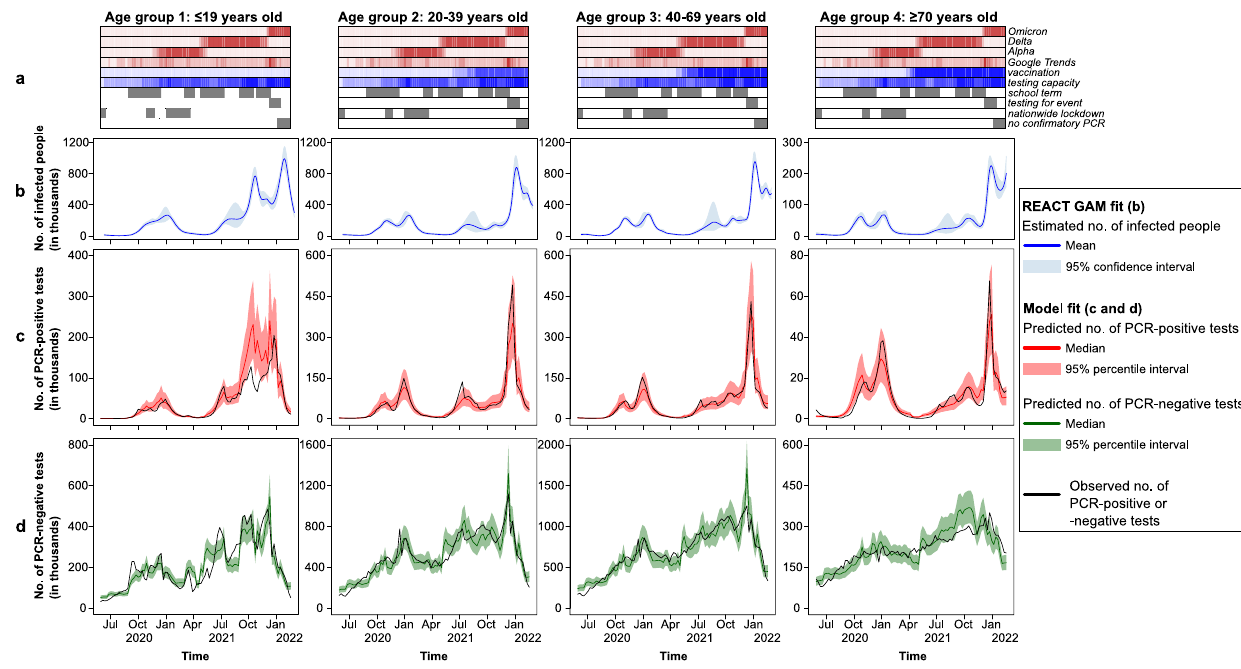
Fig. 4 | Predictive posterior check of the best- fi tting model by age group and overtime. Row a showsthetemporaltrendofvariablesincludedinthebest- fi tting model, and row b shows the temporal trend of the number of infected (mean, 95% con fi denceintervals)estimatedbyREACTGAM fi t.Row c showsthepredicted(red